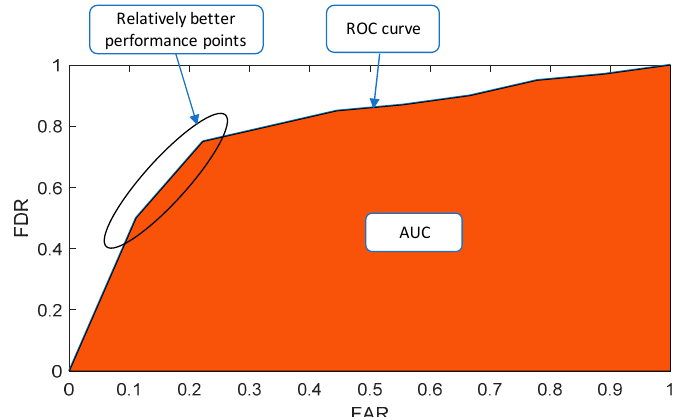
Figure 3. Receiver operating characteristics (ROC) curve and area under the ROC curve (AUC) value.